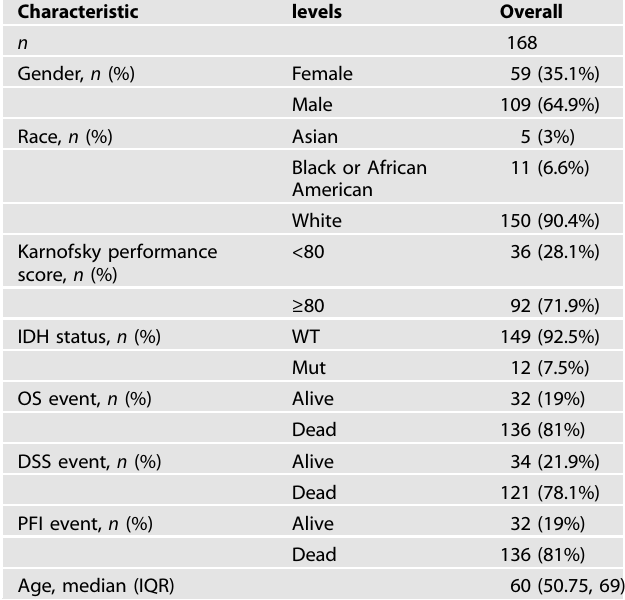
Table 1. Clinicopathological characteristics of patient samples from the TCGA GBM